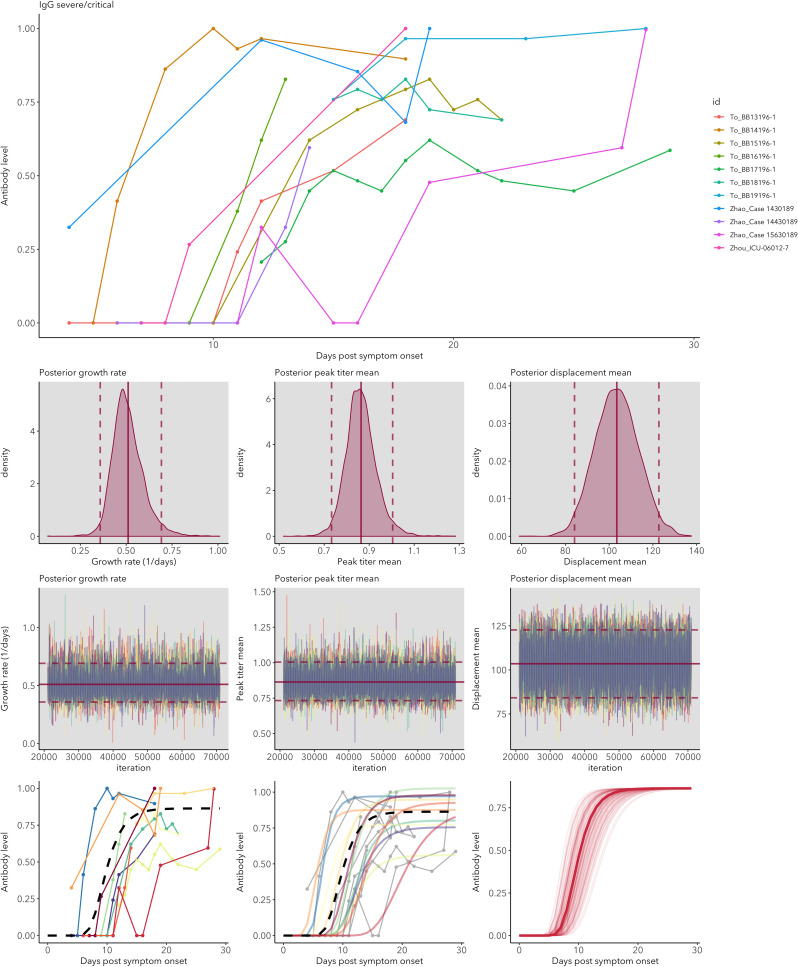
IgG severe/critical cases fitted antibody kinetics.